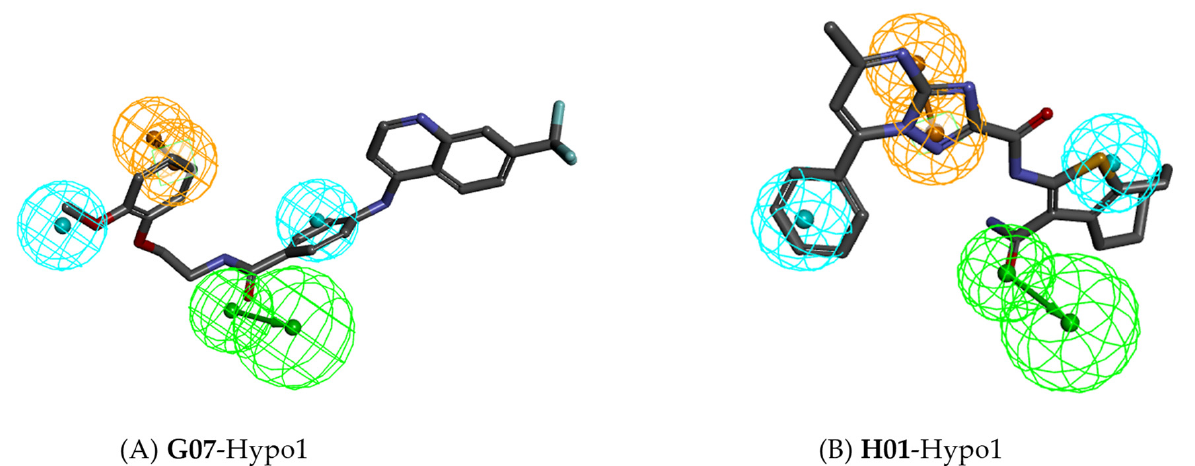
Figure 4. Pharmacophore mapping of the most active, less active compounds in the training set. ( A ) Hypo1 mapped on to the most active compound G07 ; ( B ) Hypo1 mapped on to the least active compound H01 .